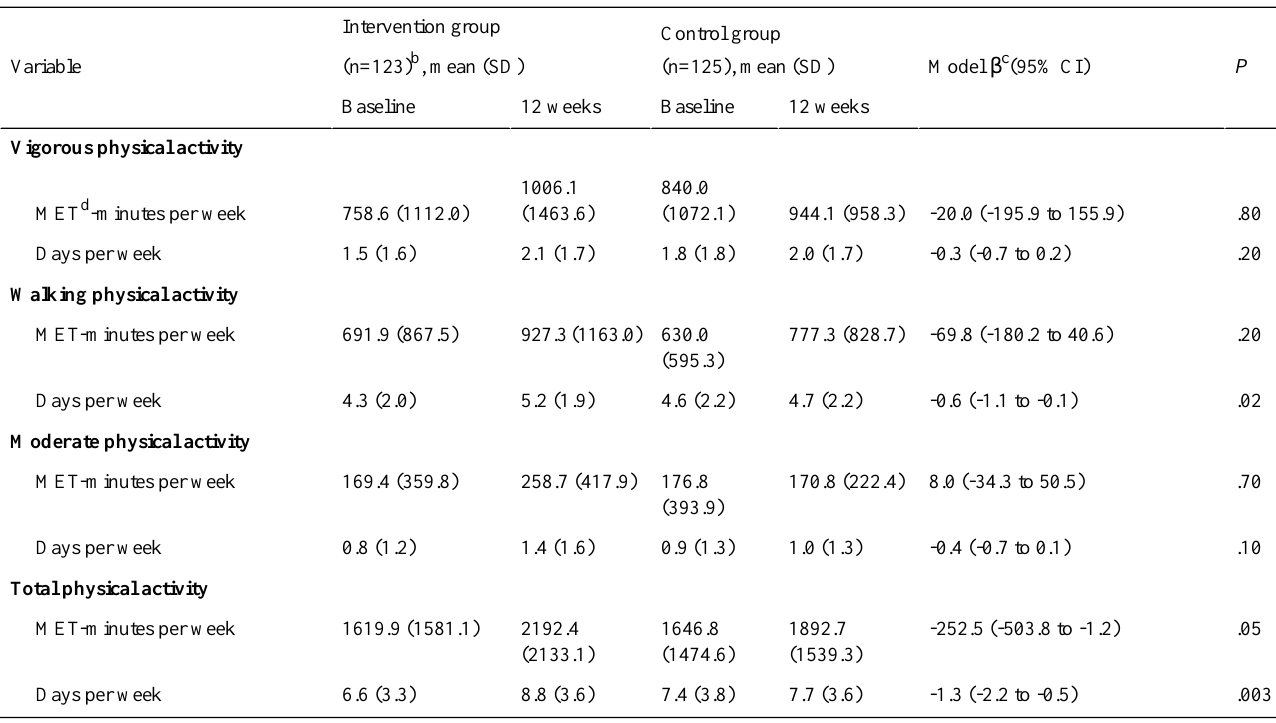
Table 5. Effect of the TXT2BFiT program on secondary physical activity outcomes from the IPAQ a for all randomized young adults in the study by allocation (intention-to-treat analysis) (n=248) b .